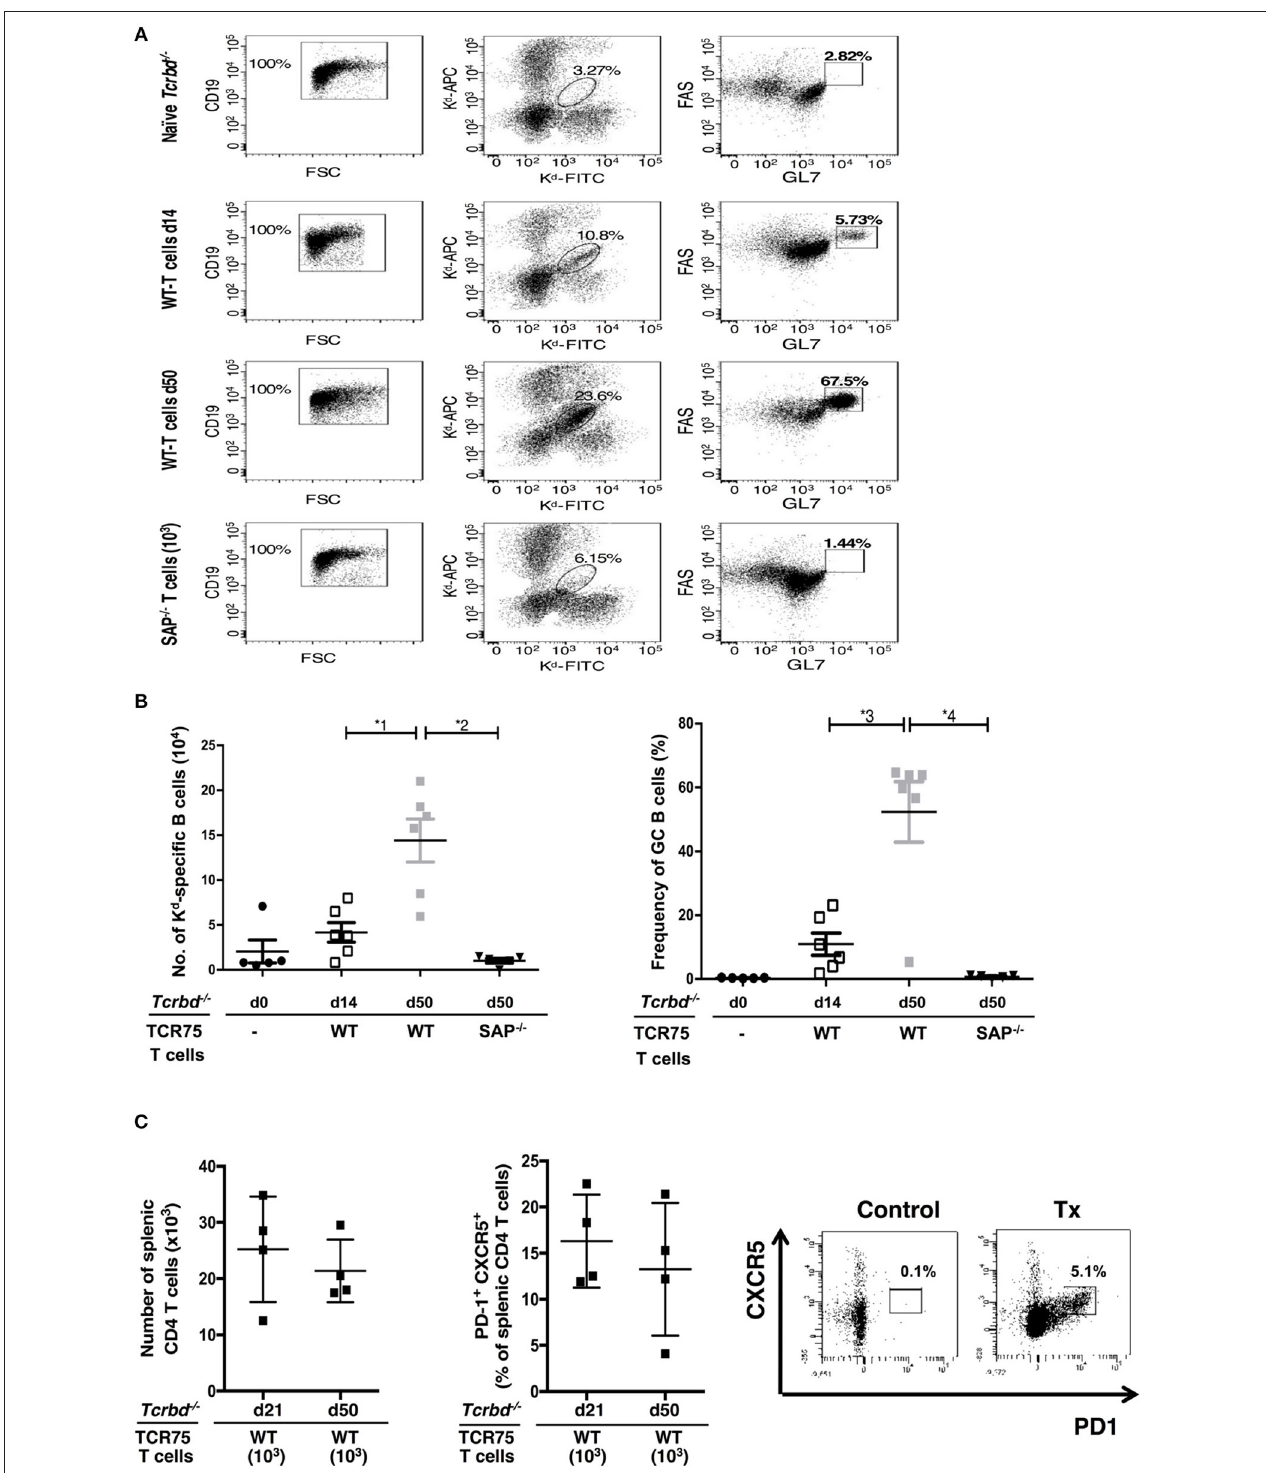
FIGURE 4 | Characterization of allospecific B cells. (A), Splenic H-2K d -specific B cells were identified by flow cytometric detection for binding of CD19 + ve B cells to FITC-conjugated and APC-conjugated synthetic H-2K d tetramers in: naïve (un-reconstituted) BL/6 Tcrbd − / − mice ( n = 5); BL/6 Tcrbd − / − mice, reconstituted with 10 3 WT TCR75 CD4T cells, 14 ( n = 6) and 50 days ( n = 6) after challenge with BALB/c heart allografts; and at 50 days after transplantation with BALB/c hearts and